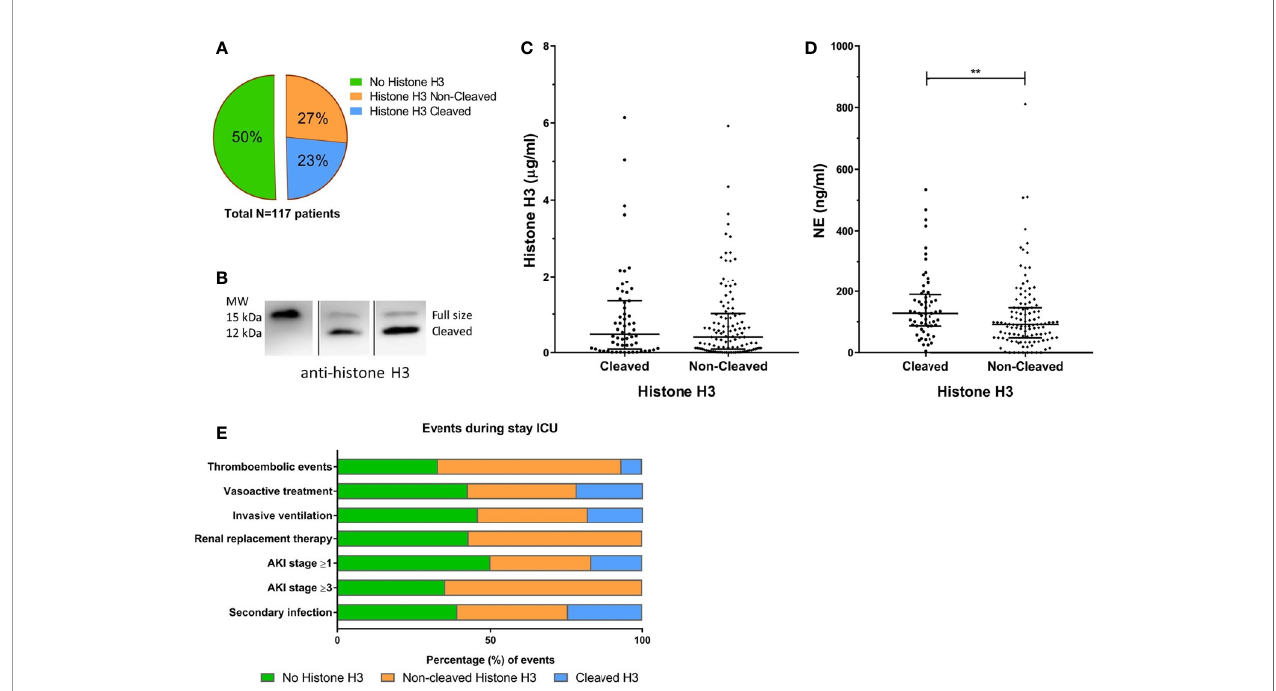
FIGURE 2 | Histone H3 cleavage in COVID-19 patients. The fraction of patients with detectable cleaved or non-cleaved histone H3 (A) . Western blot analysis using a polyclonal anti-histone H3 antibody allowed detection of proteolytic cleavage of histone H3, distinguishing between full-sized histone H3 (15 kDa) and a histone H3 fragment (12 kDa) (B) . The concentration of histone H3 (C) or NE (D) in cleaved or non-cleaved histone H3 positive samples. The percentage (%) for the positive amount of signi fi cantly different clinical events during the stay at the ICU (E) . Acute kidney injury (AKI). P-values were considered signi fi cant if p < 0.05; *0.05, **0.01,